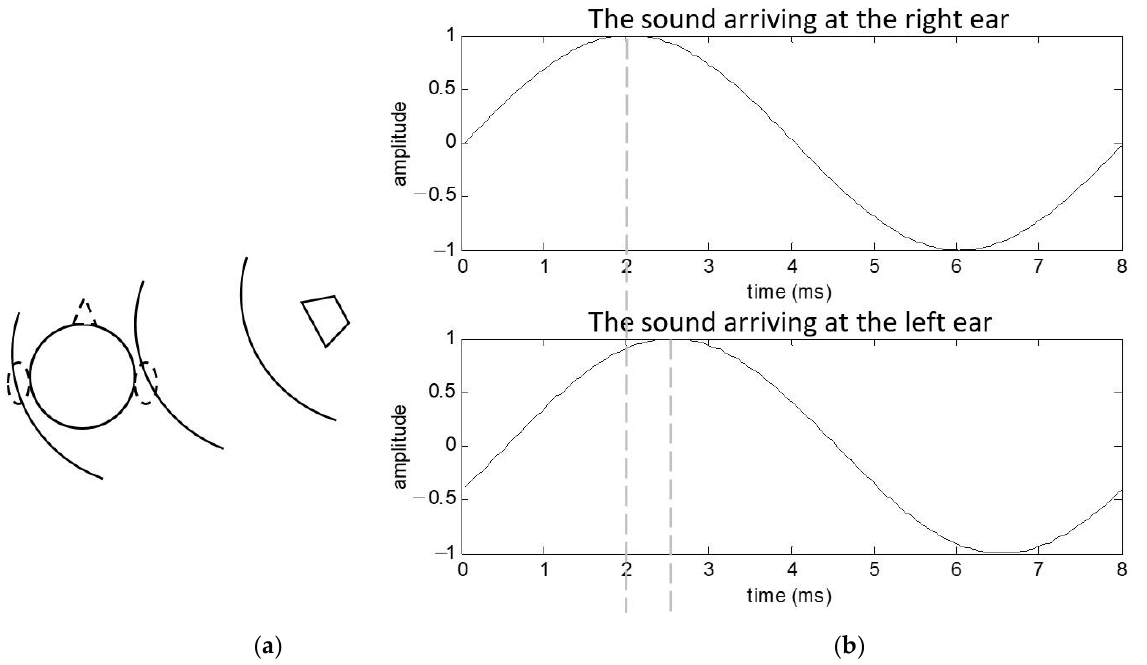
Figure 2. Transmission pattern of ( a ) low-frequency and ( b ) high-frequency sound.